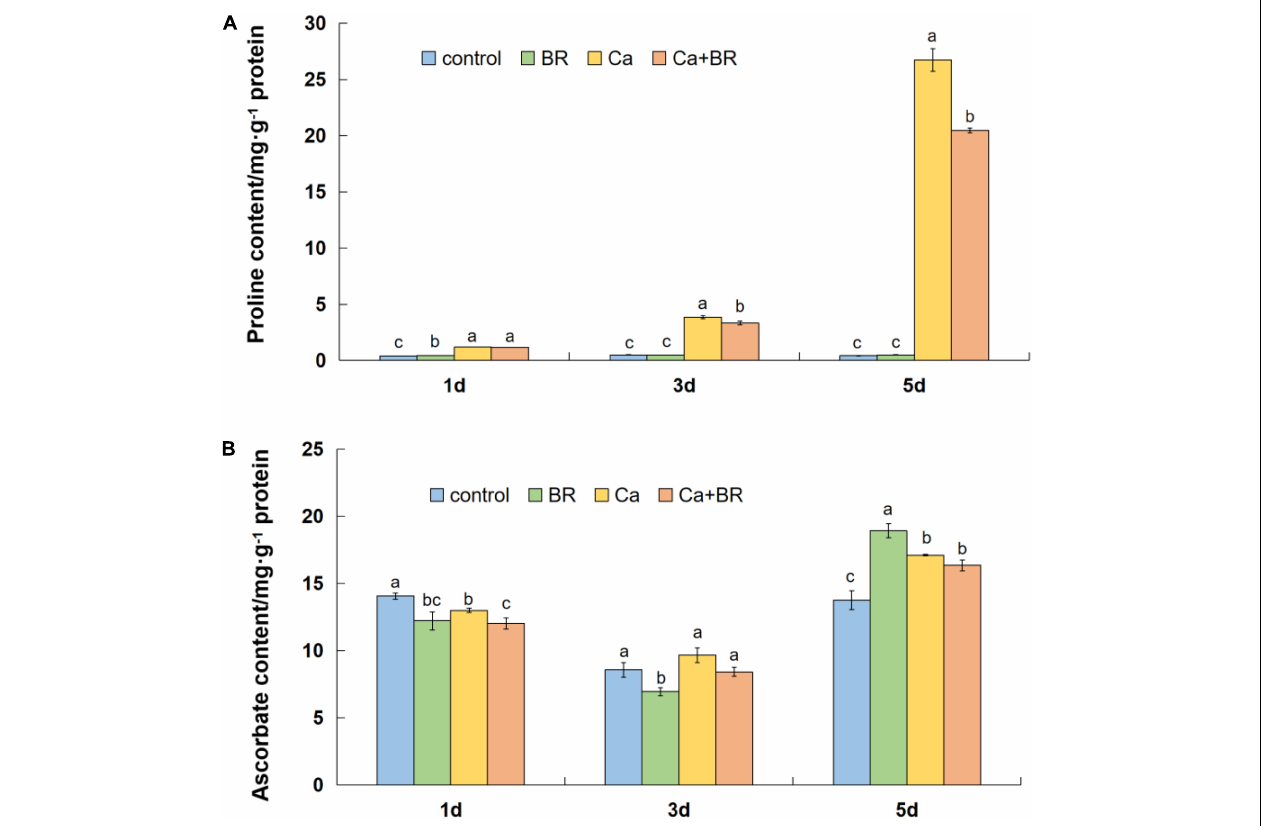
FIGURE 6 | (A) Proline and (B) ascorbic acid content in the leaves of the tomato seedlings subjected to Ca(NO 3 ) 2 , foliar spraying with BR, or their combinations. BR, 0.1 µ mol/L brassinolide; Ca, 100 mmol/L Ca(NO 3 ) 2 ; Ca+BR, 100 mmol/L Ca(NO 3 ) 2 stress plus foliar spraying exogenous BR. Each data point represents the mean of three independent biological replicates (mean ± SD). Different letters above the bars indicate statistically significant differences ( P <